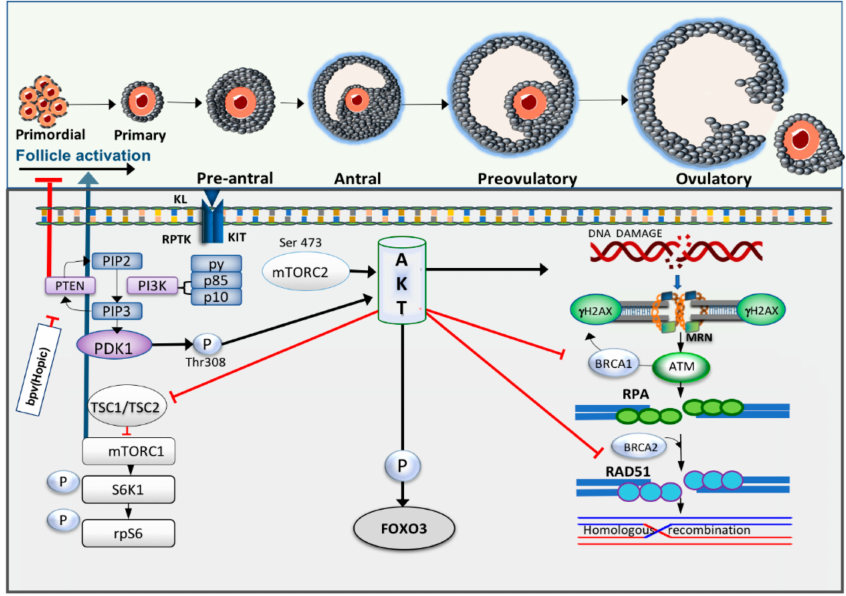
Figure 3. Crosstalk between primordial follicle activation and DDR pathway. Receptor protein tyrosine kinase (RPTK) Kit and its ligand activate phosphoinositide 3-kinase (PI3K) and as a response to this activation, the catalytic subunits of PI3K, p85 and p110, will be activated. In turn, it converts phosphatidylinositol-4,5-bisphosphate (PIP2) to phosphatidylinositol-3,4,5-bisphosphate (PIP3), which then serves as the second messenger to enable phosphoinositide-dependent kinase-1 (PDK1) activation. Phosphatase and tensin homolog deleted on chromosome 10 (PTEN) reverses this process and increases PIP2expression. PDK1andAktarerecruitedthroughbindingoftheirpleckstrinhomology(PH)domains to PIP3, leading to phosphorylation of protein kinase B (Akt) by PDK1. Akt activation consequently triggers phosphorylation of forkhead box O3 (FOXO3) resulting in cytoplasmic localisation of this transcription factor. Increased in Akt activity also induces phosphorylation of mammalian target of rapamycin complex I (mTORC1) through inactivation of tuberous sclerosis complex 1 and 2 (TSC 1, 2). S6 protein kinase (S6K) activity is then upregulated and simultaneously triggers phosphorylation of ribosomal protein S6 (rpS6). Meanwhile, high intracellular levels of Akt have been reported to increase DNA damage, repress nuclear translocation of breast cancer susceptibility gene 1 ( BRCA1 ) and compromise homologous recombination (HR) in breast cancer